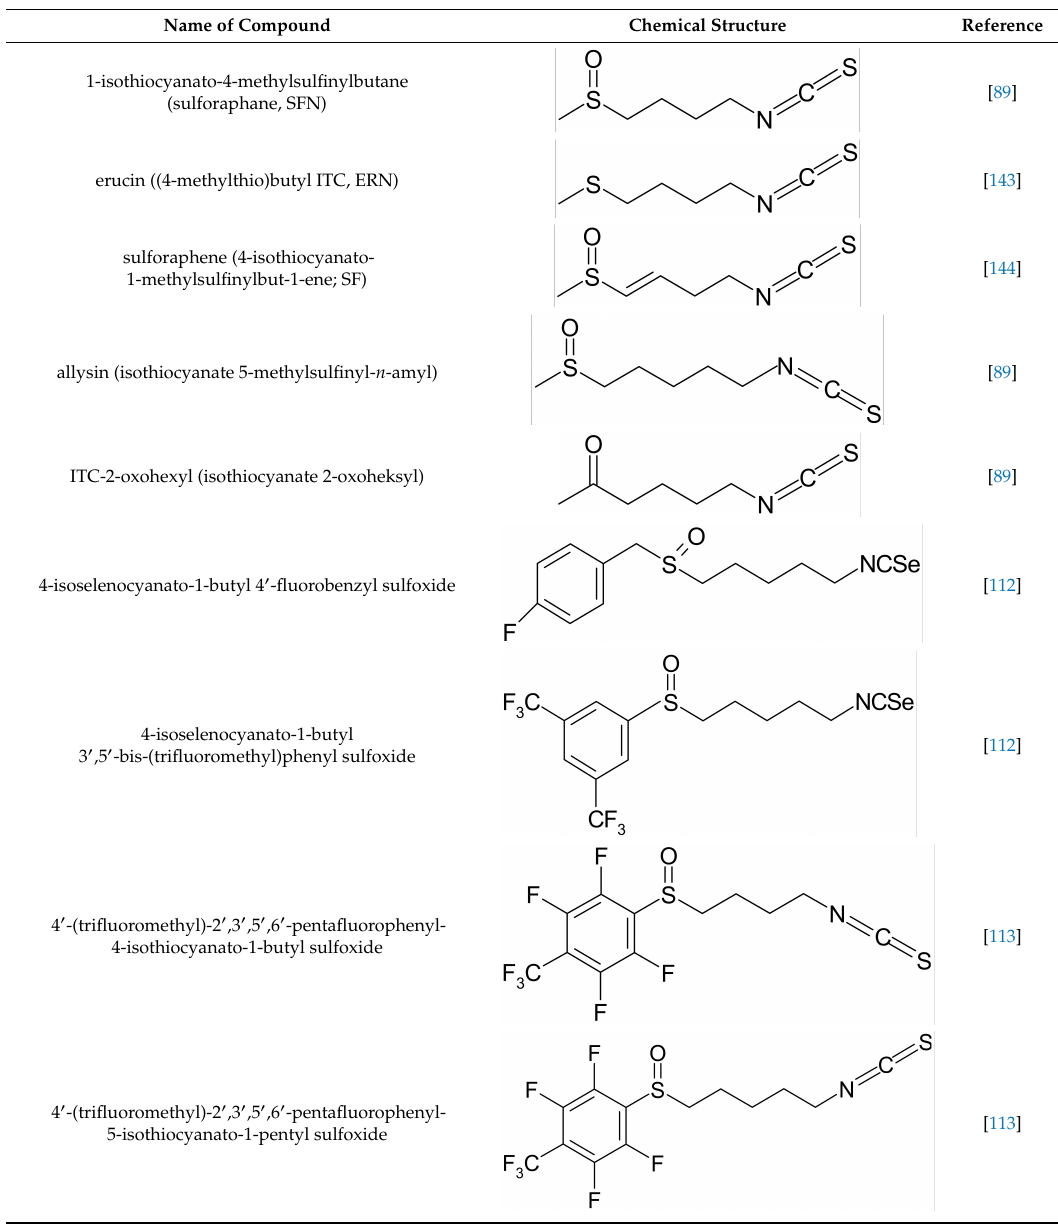
Table 6. Chemical structures of SFN